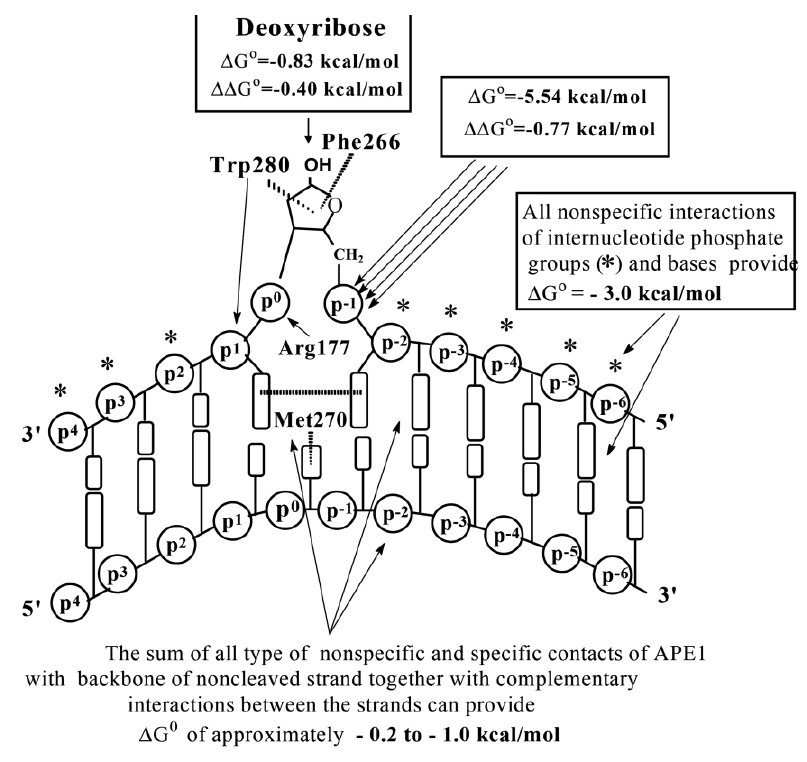
Figure 8. The thermodynamic model of apurinic/apyrimidinic endonuclease (APE1) interaction with specific DNA containing abasic (AP)-site. All types of contacts are shown on the Panel [69].